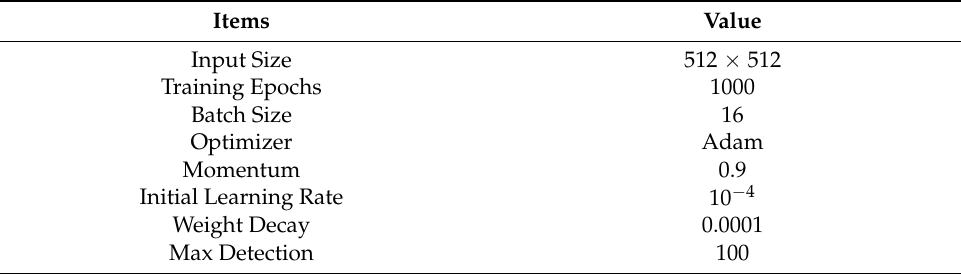
Table 2. Initial key parameters of the detection